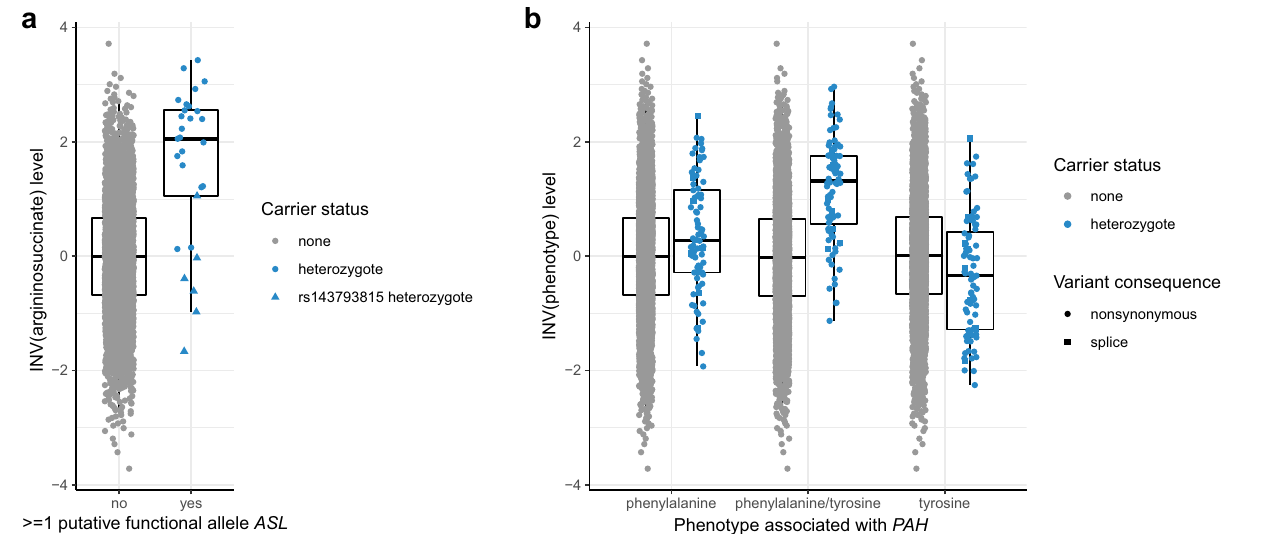
Fig. 3 Effect size on metabolite levels (Y-axis) versus rare variant carrier status (X-axis). Argininosuccinate levels are displayed by ASL rare variant carrier status ( a ) and levels of phenylalanine, tyrosine and their ratio for PAH rare variant carrier status ( b ). The Y axis represents metabolite levels after inverse normal transformation (INV), which allows for comparisons across metabolites. Units correspond to standard deviations. The symbol color indicates observed rare variant carrier status, and symbol shape variant consequence. The box ranges from the 25 th to the 75 th percentile of transformed metabolite levels, the median is indicated by a line, and whiskers end at the last observed value within 1.5*(interquartile range) away from the box. Sample sizes: n = 4863 individuals for argininosuccinate; n = 4839 individuals for phenylalanine, phenylalanine/tyrosine ratio and